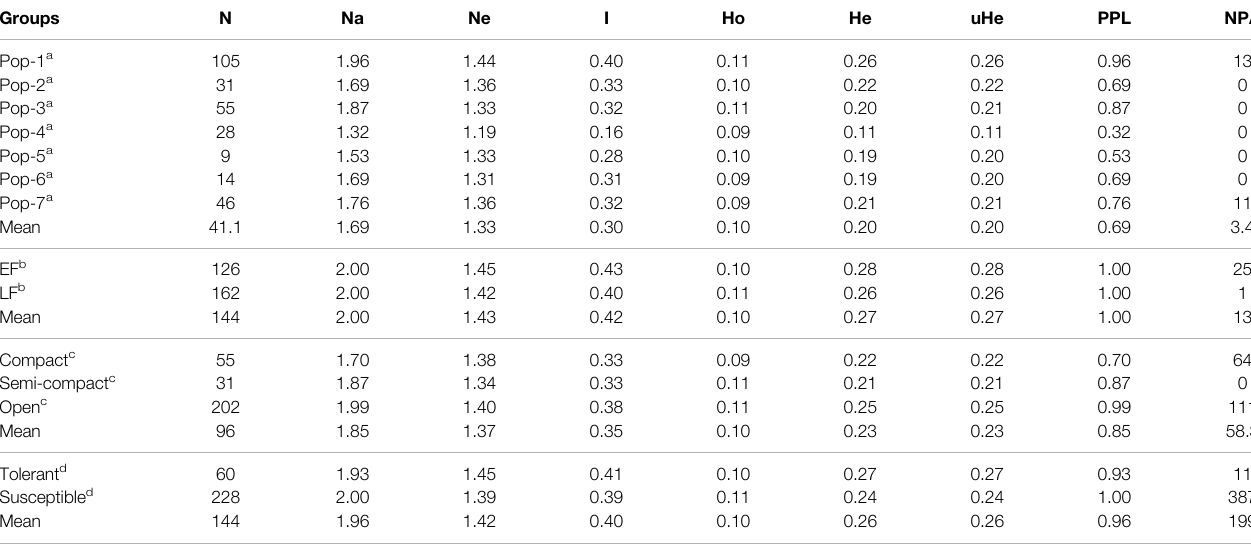
TABLE 1 | Estimates of different genetic diversity parameters for different groups of fi nger millet accessions: mean values for the observed number of alleles (N A ), effective number of alleles (Ne), Shannon ’ s information index (I), observed heterozygosity (Ho), expected heterozygosity (He), unbiased genetic diversity (uHe), percentage of polymorphic loci (PPL), and number of private alleles (NPA). Groups N